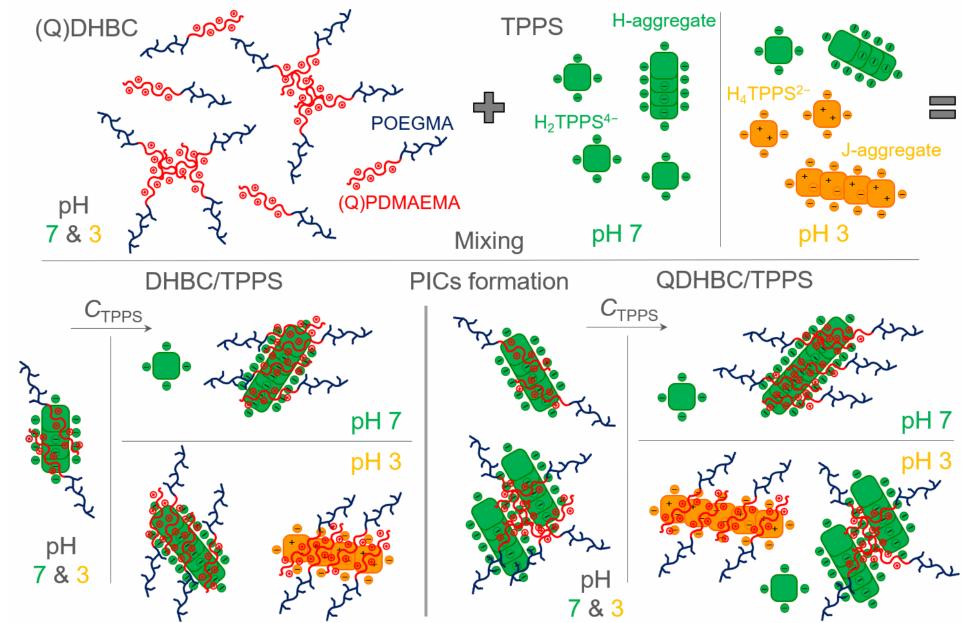
Scheme 2. Proposed interaction illustration for the formation of PICs between the DHBC or its quaternized counterpart QDHBC and TPPS porphyrin at different pH values and porphyrin